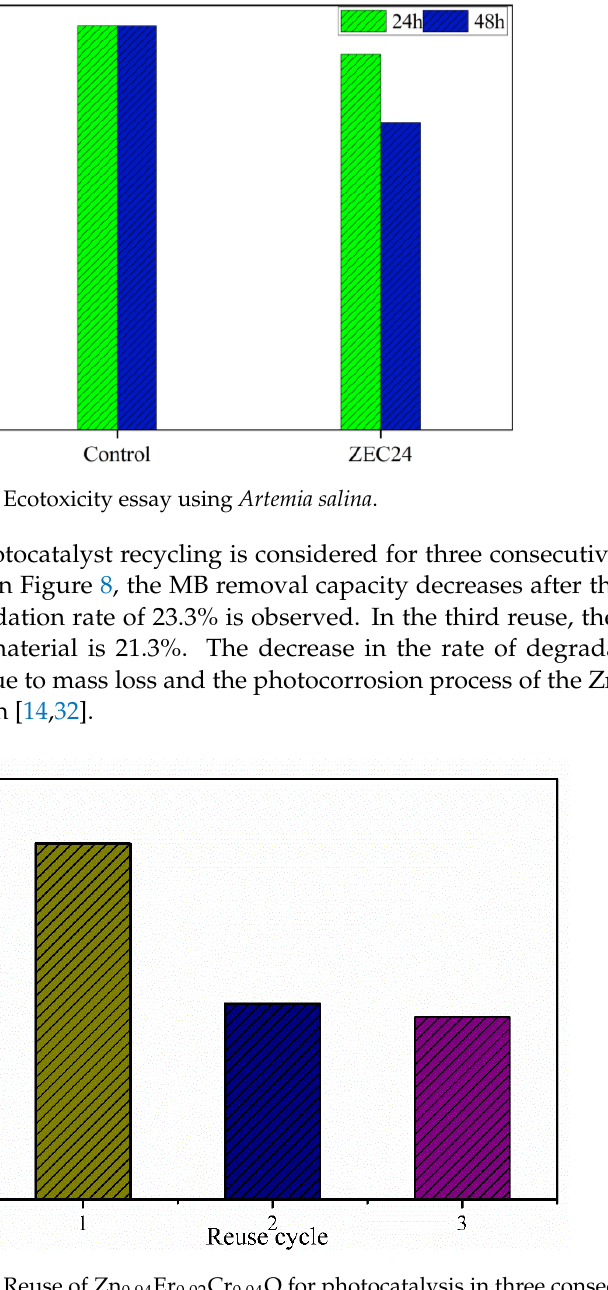
Figure 6. Photocatalytic mechanism of Zn 0.94 Er 0.02 Cr 0.04 O material.